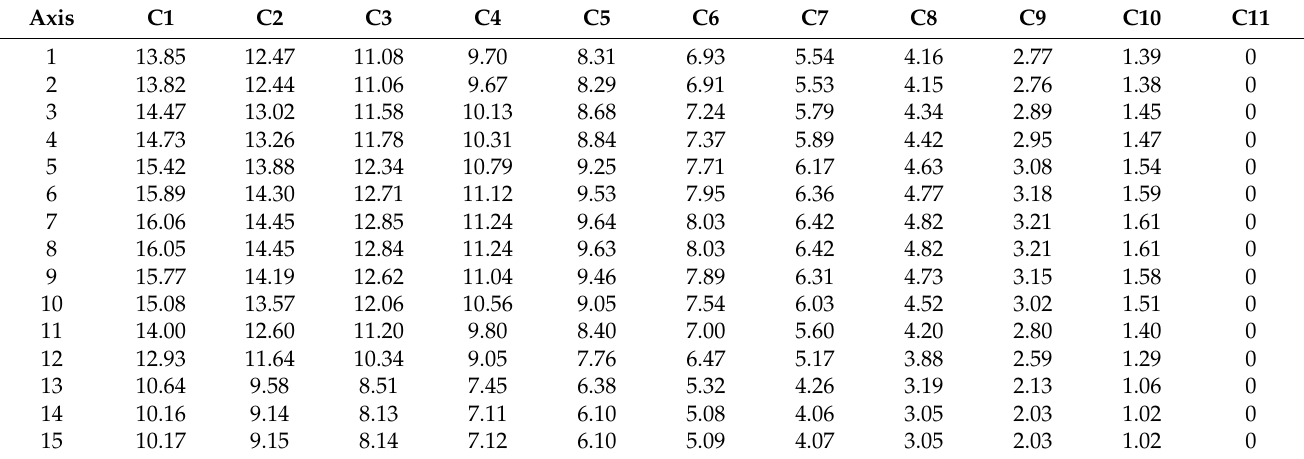
Table 7. Length of traction cable under various calculation conditions